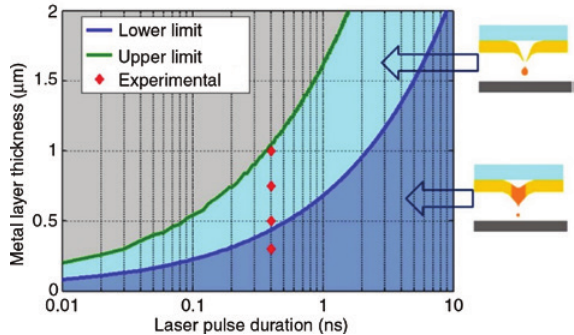
Figure 4: Calculated ranges of metal donor film thicknesses allowing the transfer of a single copper microdroplet for pulse durations varying from 10 ps to 10 ns.